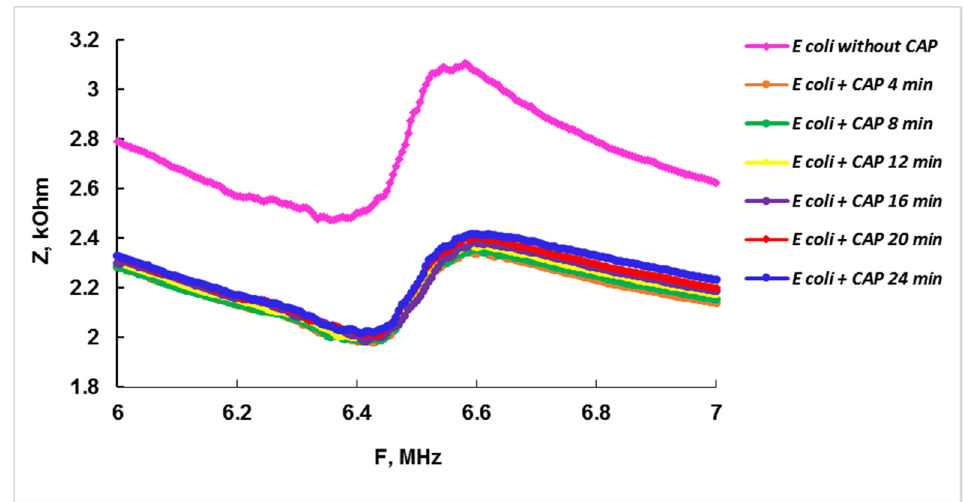
Figure 7. The frequency dependences of the electrical impedance modulus of a compact analyzer with a suspension of E. coli K-12 cells before (pink curve) and after the CAP exposure with the concentration of 2 mg/mL for 4, 8, 12, 16, 20, and 24 min.